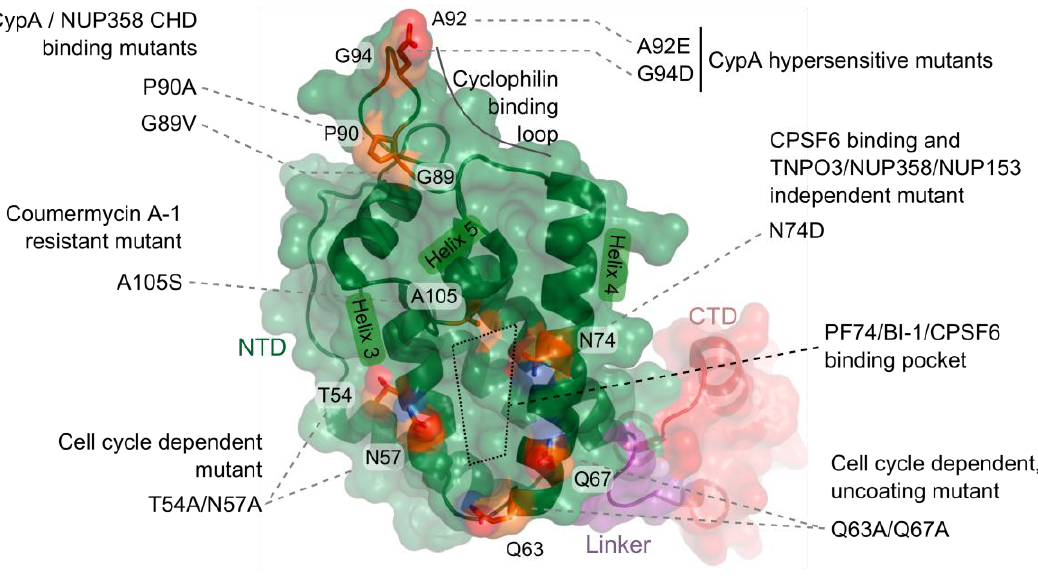
Figure 3. Schematic of HIV-1 capsid (CA) and mutations described in the text. A single HIV-1 CA monomer (protein database code 3j34) is represented by a cartoon of the peptide backbone, as well as a semi-transparent surface representation: N-terminal domain (NTD), green; flexible linker, purple; C-terminal domain (CTD), red. A subset of CA residue side-chains that exhibit phenotypic differences in preintegrative steps of HIV-1 infection are shown as sticks and colored as follows: carbon, orange; nitrogen, blue; oxygen,